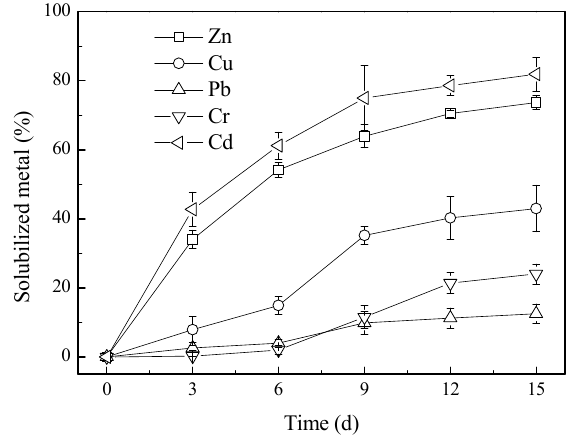
Figure 4. Heavy metals solubilization during bioleaching with sulfur powder.